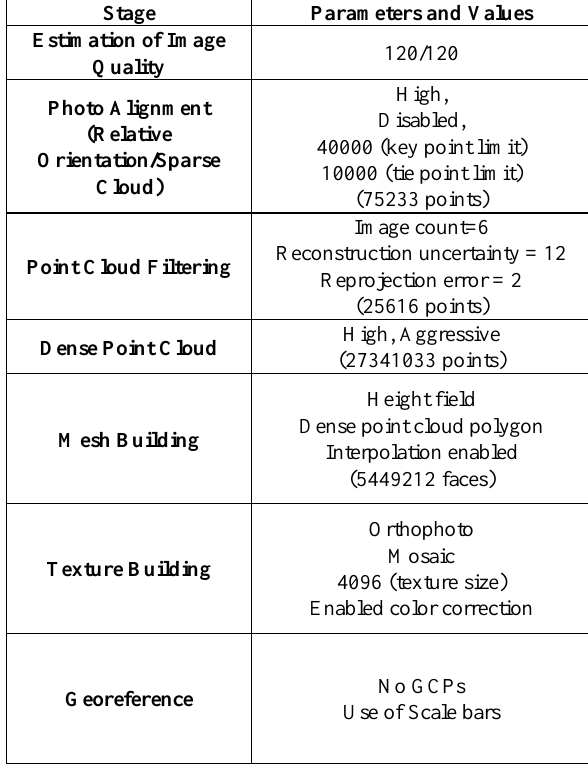
Table 2. Parameters used for the creation of the reference